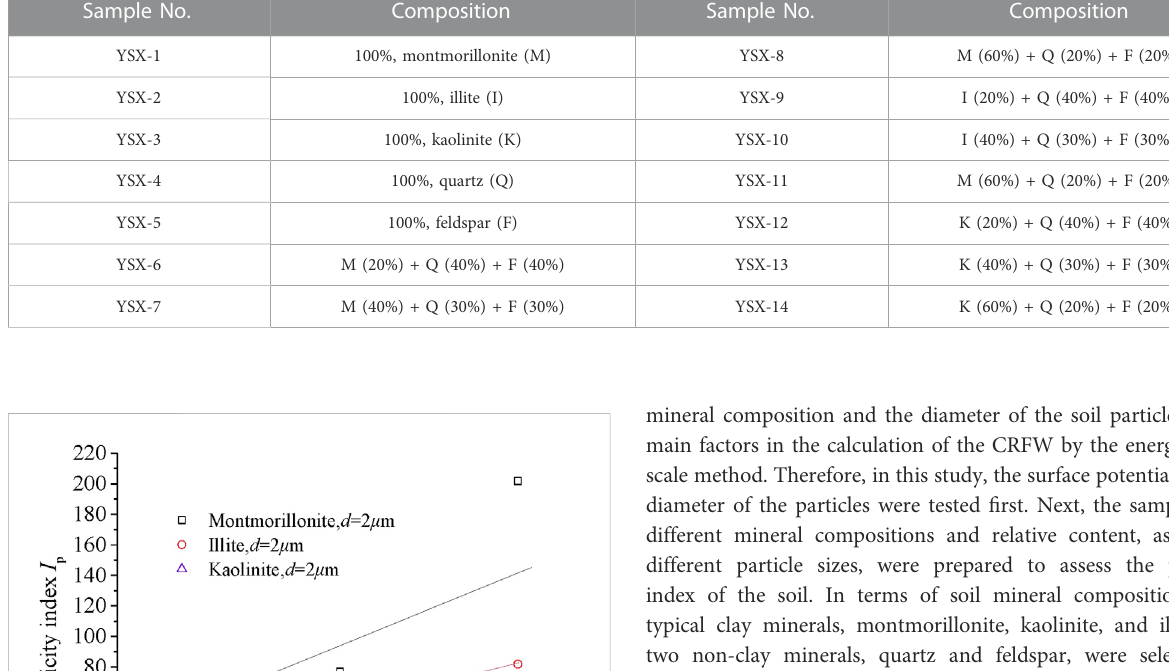
TABLE 1 Sample characteristics. Sample No.